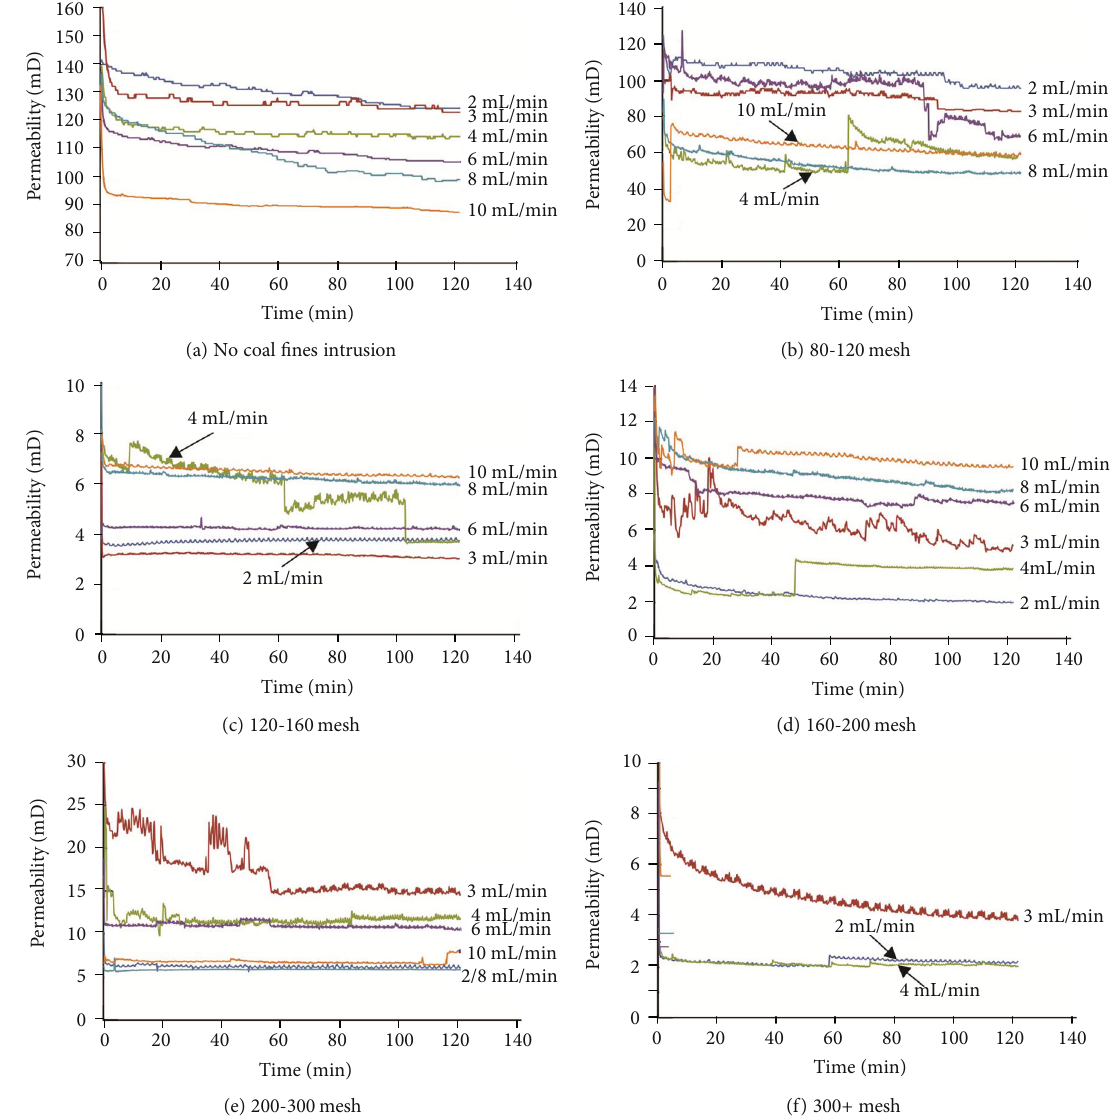
Figure 9: Permeability evolution under di ff erent fl ow velocity (con fi ning pressure of